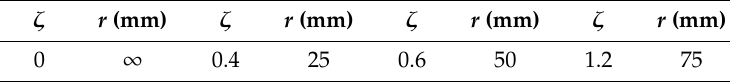
Table 3. Correspondence of ζ and r .